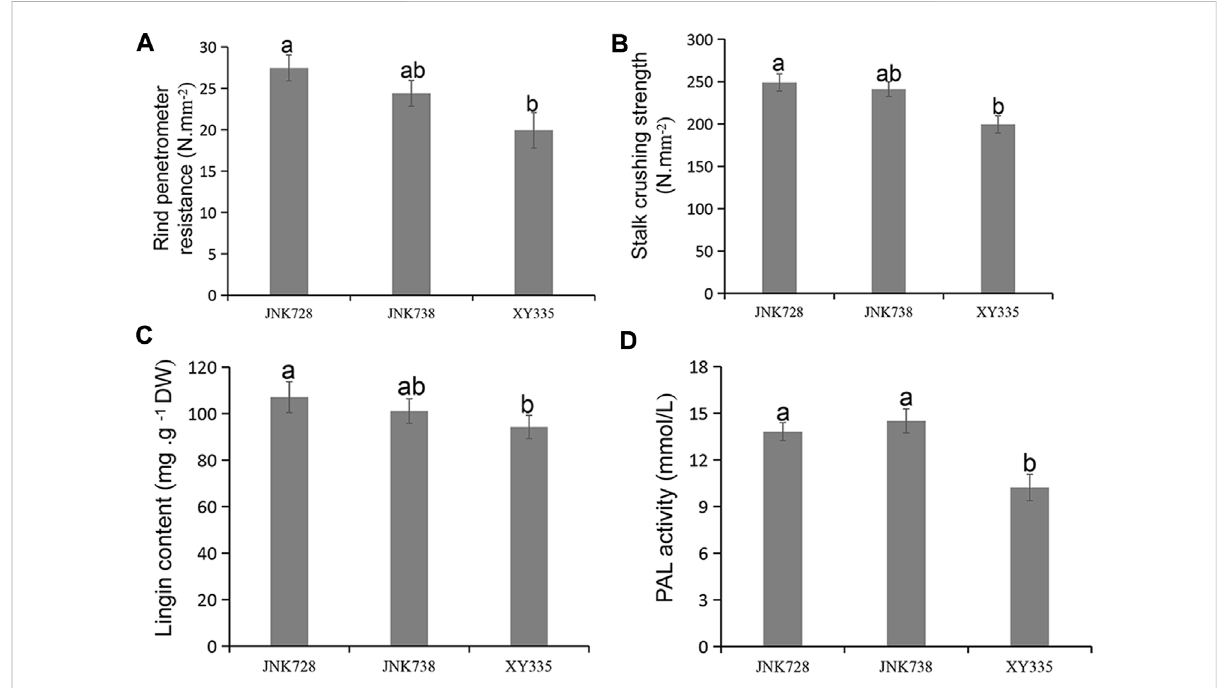
FIGURE 1 Mechanical index and physiological parameters of the three hybrid cultivars. (A) Rind penetrometer resistance, (B) stalk crushing strength, (C) lignin content, and (D) PAL activity. Data are presented as means ± SE ( n = 3). Different letters above line graphs show a signi fi cant difference ( p ≤ 0.05) among the three